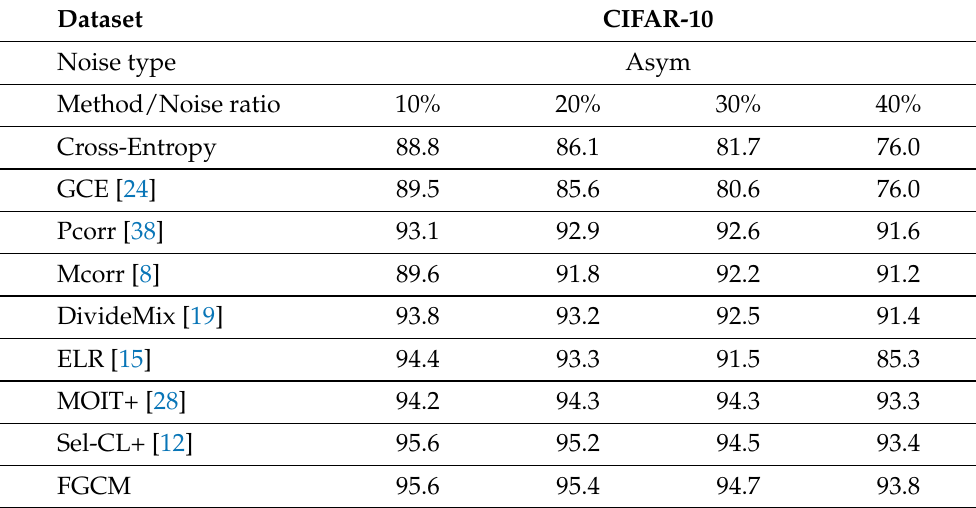
Table 3. Performance comparison with state-of-the-art methods on CIFAR-10 with different ratios of asymmetric noise as PreAct-18 resnet being the backbone.